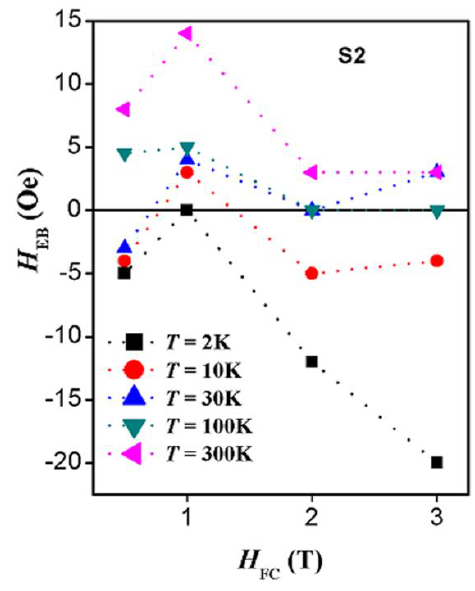
Figure 8. The field-cooling dependence of H EB in sample S2 at several temperatures.